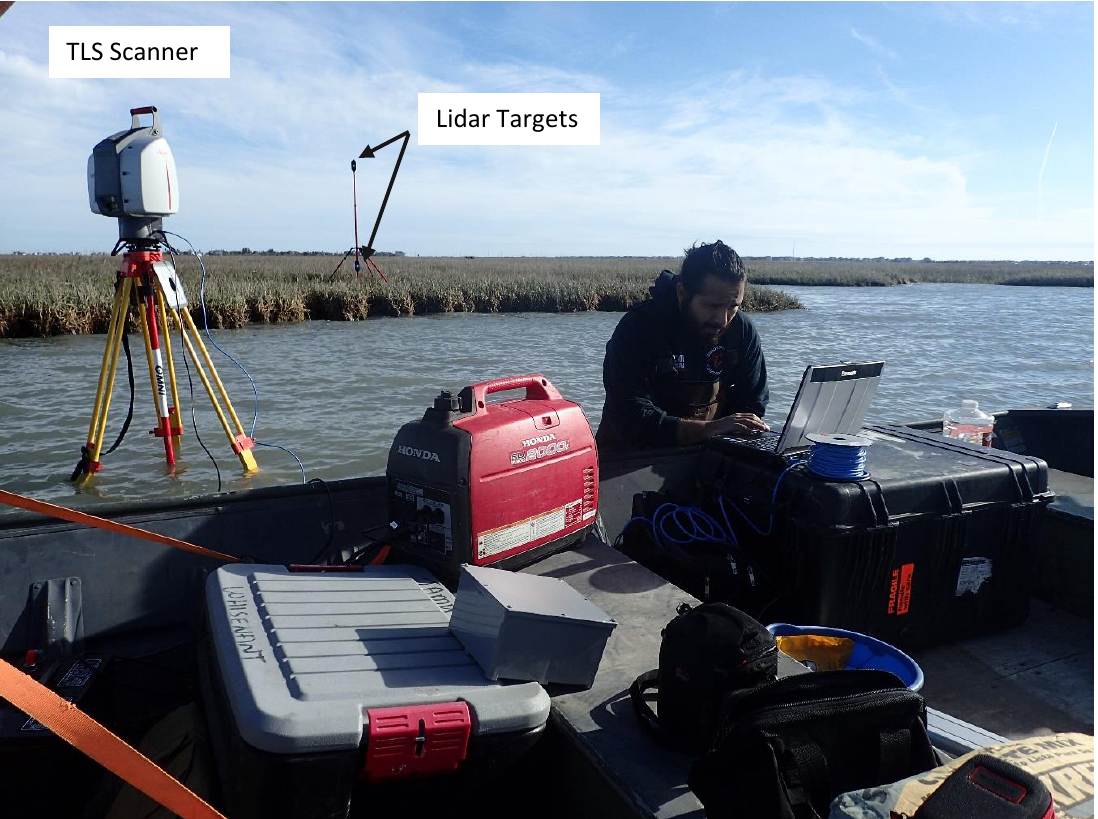
Figure 2 . Photo of the Terrestrial Laser Scanning (TLS) scan assembly. The scanner tripod is placed over a concrete survey marker with reflective Light Detection and Ranging (lidar) targets on concrete benchmarks atop the marsh surface.